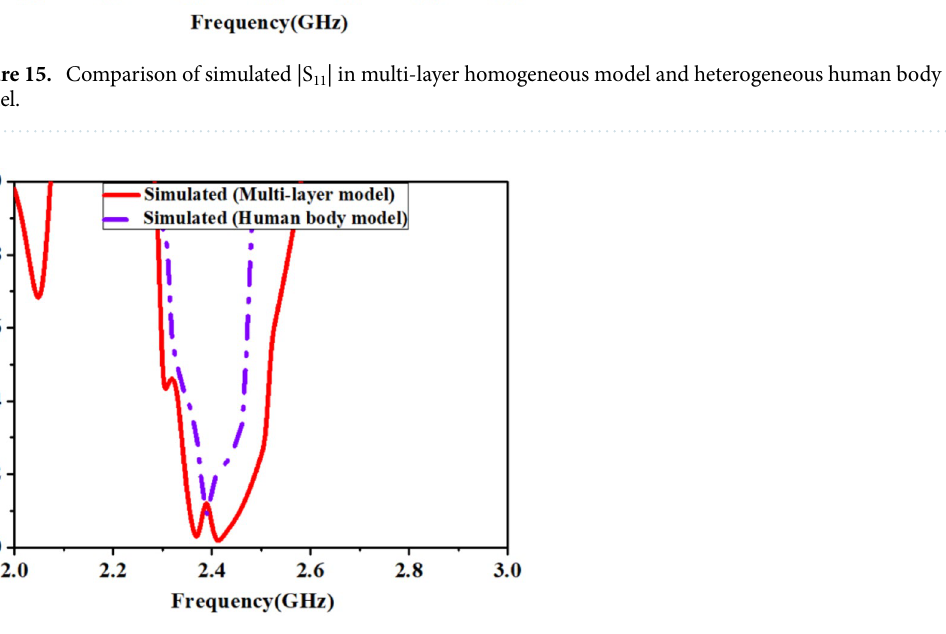
Figure 16. Comparison of simulated A.R in multi-layer homogeneous model and heterogeneous human body model.